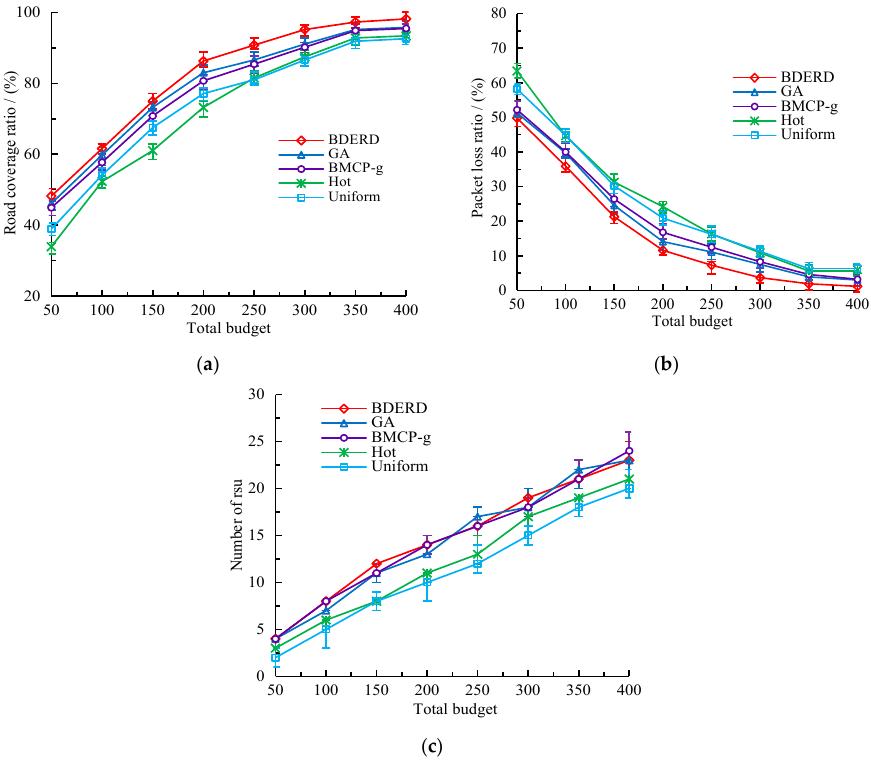
Figure 6. ( a ) Road coverage ratio versus the total budget; ( b ) packet loss ratio versus the total budget; ( c ) number of roadside units (RSUs) versus the total budget.